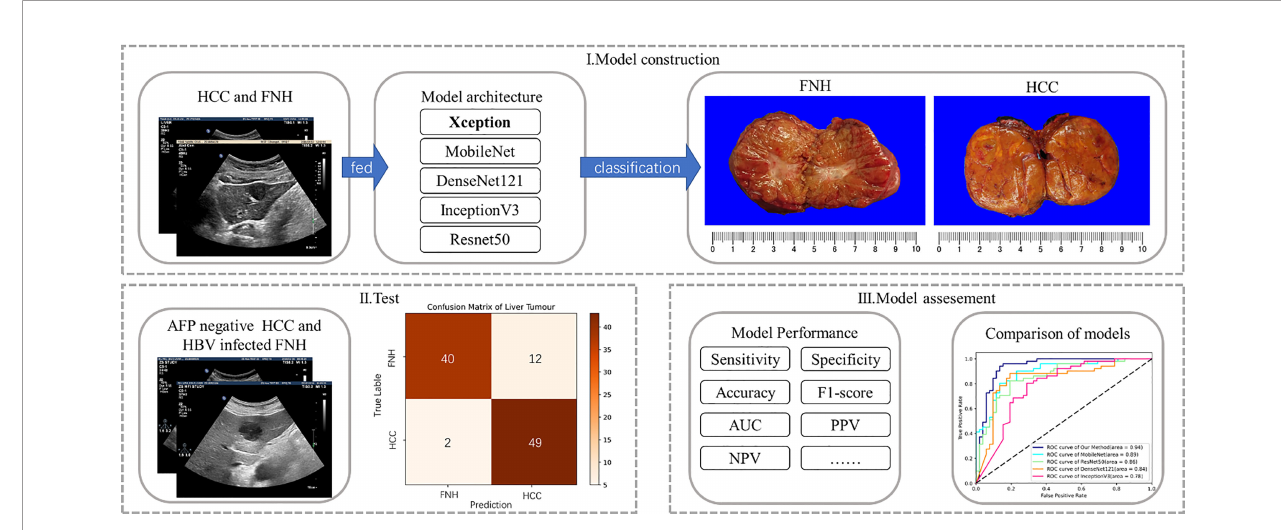
FIGURE 1 | Flowchart of deep learning model construction and analysis: (i) obtained grayscale images of the model cohort were fed into fi ve deep learning models for training and model construction; (ii) selected lesions of the test cohort with similar clinical backgrounds were tested; and (iii) the fi ve deep learning models were assessed in terms of diagnostic